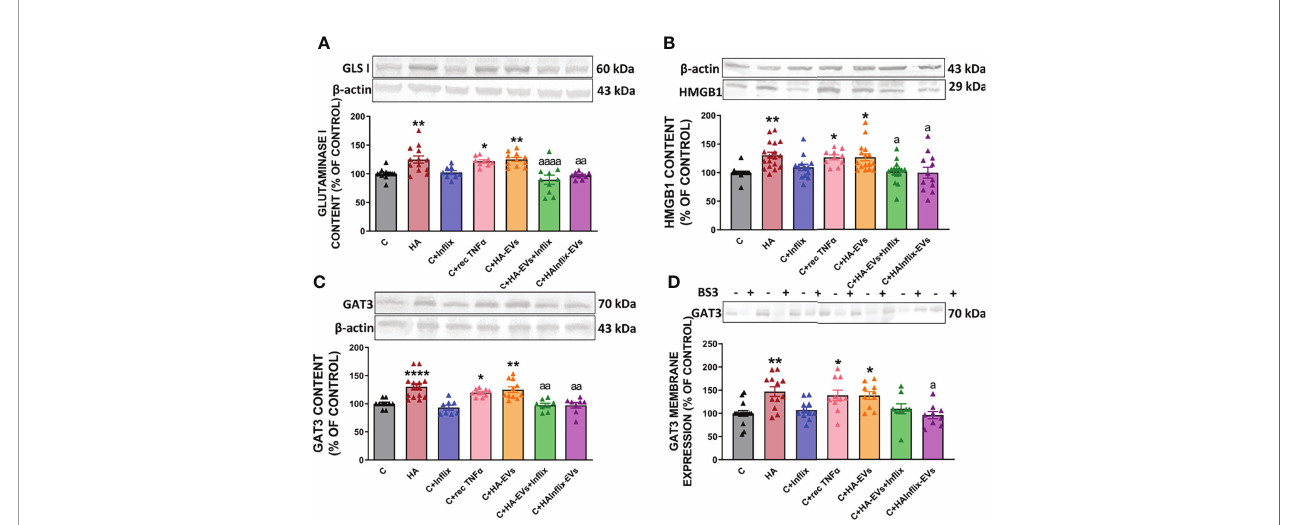
FIGURE 5 | Extracellular vesicles from hyperammonemic rats activate glutaminase-GAT3 pathway in cerebellar slices from control rats. Protein content of (A) glutaminase I (n=9-13), (B) HMGB1 (n=10-18) and (C) GAT3 (n=8-14) measured by Western blot in cerebellar slices. (D) Membrane expression (n=9-15) of GAT3 measured by Western blot in cerebellar slices incubated with or without BS3. Representative images of Western blot bands and loading control are shown and molecular weight of each protein is indicated. Sample size indicates number of animals. Values are expressed as percentage of control and are the mean±SEM. Values signi fi cantly different from controls are indicated by asterisk (*p<0.05, **p<0.01, ****p<0.001) and values signi fi cantly different from C+HA-EVs group are indicated by a (a = p<0.05, aa = p<0.01, aaaa =